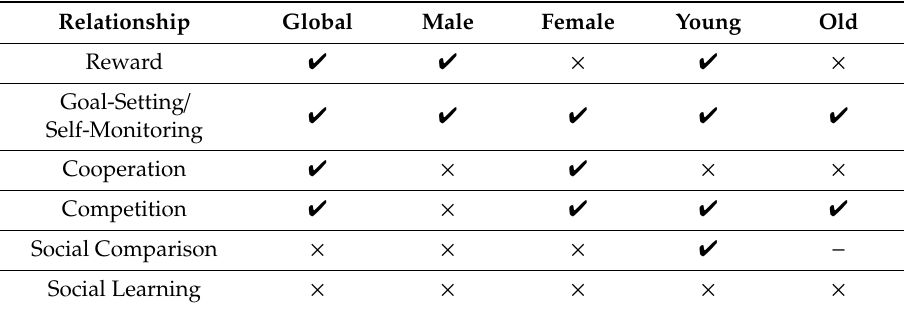
Table 7. Summary of the relationship between persuasive features and intention to